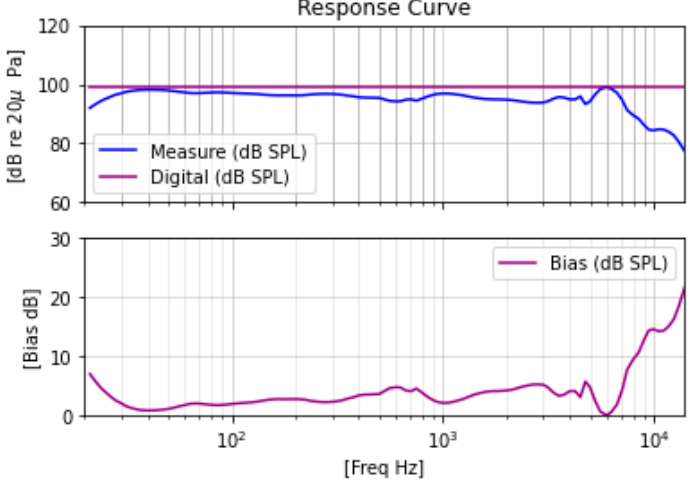
Figure 4. Speaker Frequency Response measurement and SPL bias for dose calculation.